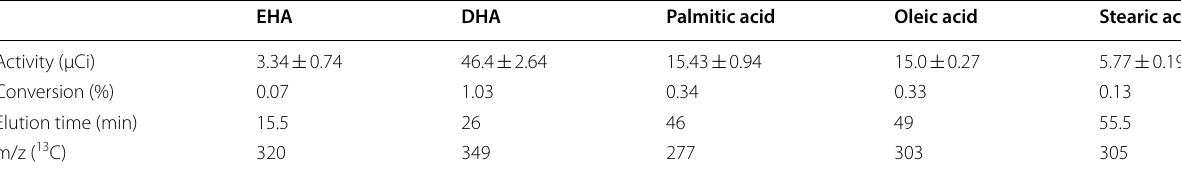
EHA eicosahexaenoic acid